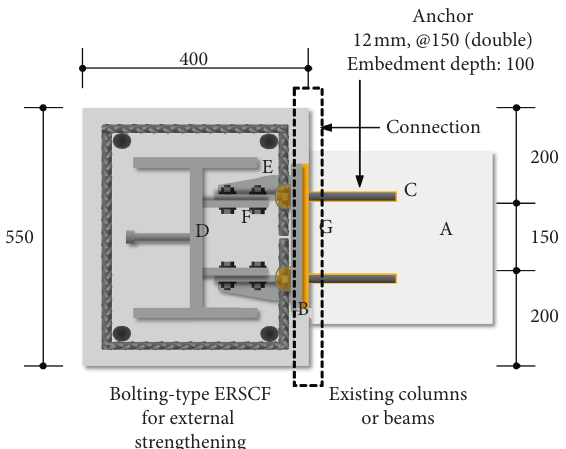
Figure 3: Detailed diagram of a connection element and technical details of the bolted ESRCF strengthening Table 2: Construction procedure for the bolted ESRCF strengthening system. Sequence